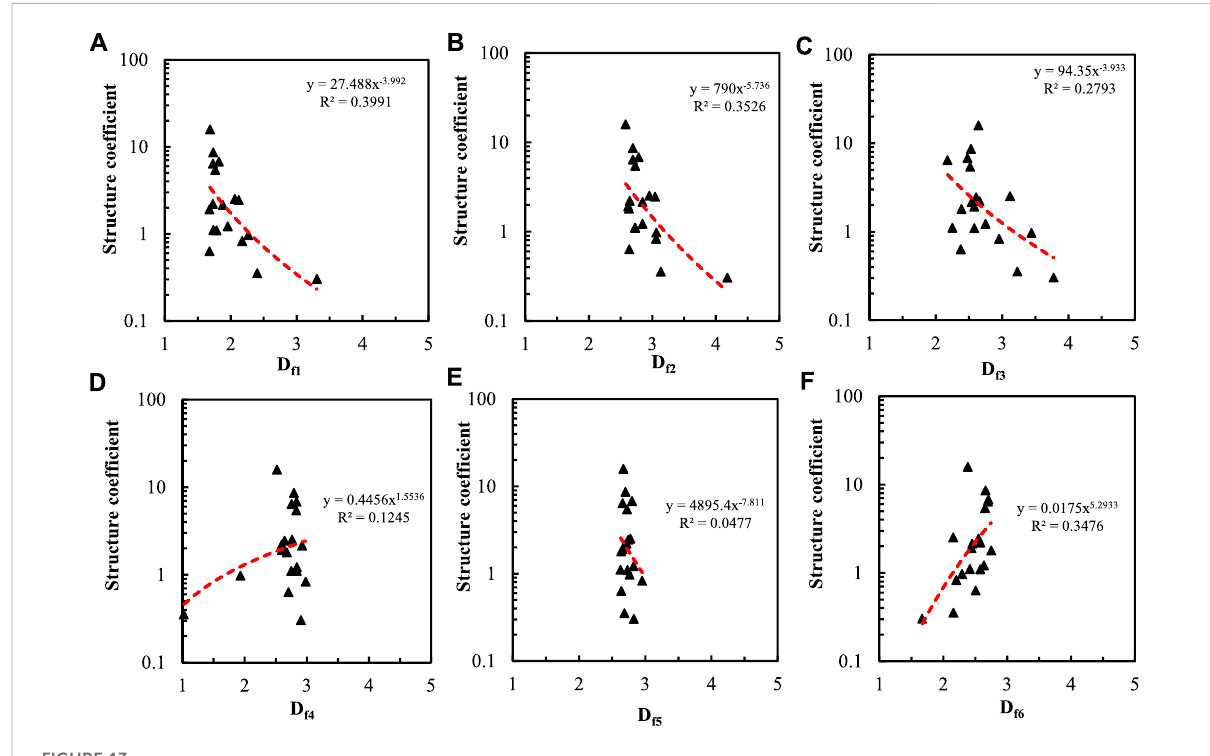
FIGURE 13 Relationship between structure coef fi cient and fractal dimension calculated by six